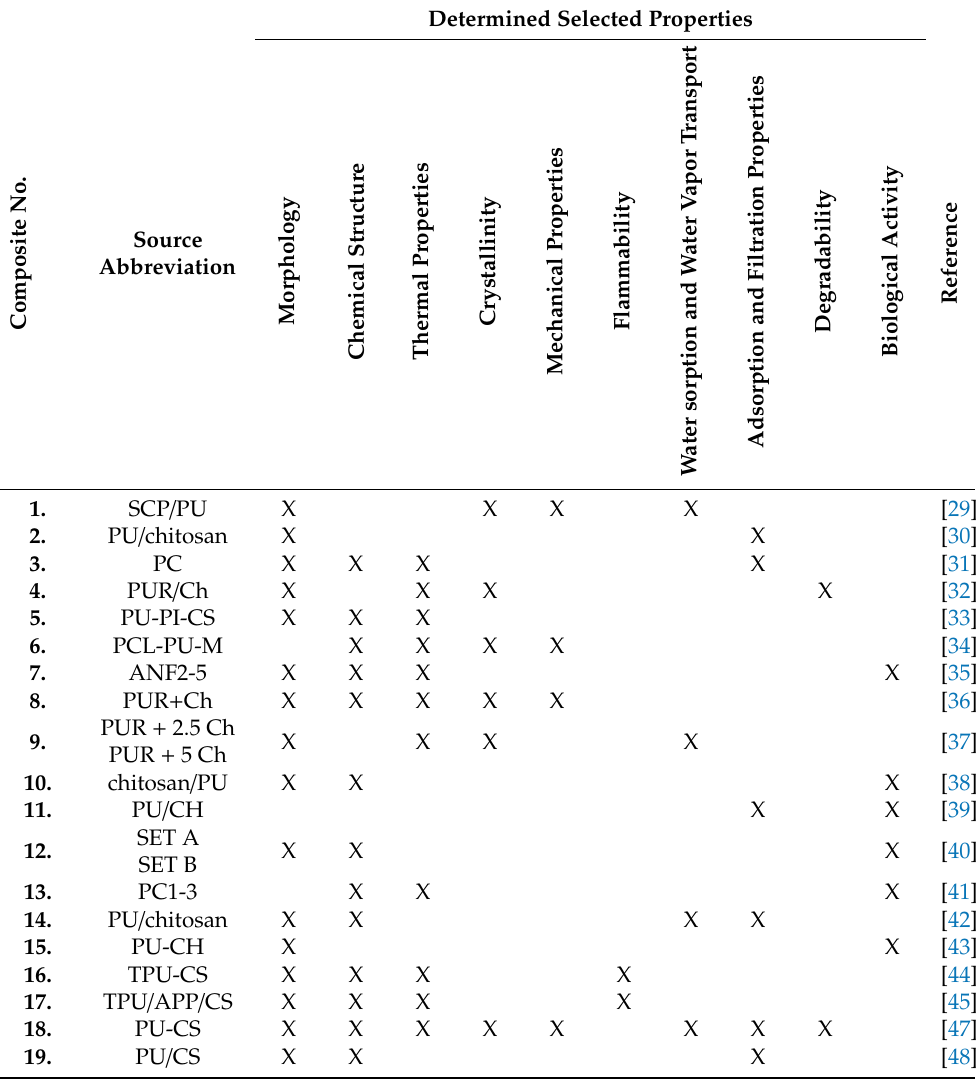
Table 2. Juxtaposition of discussed PUR / Chit